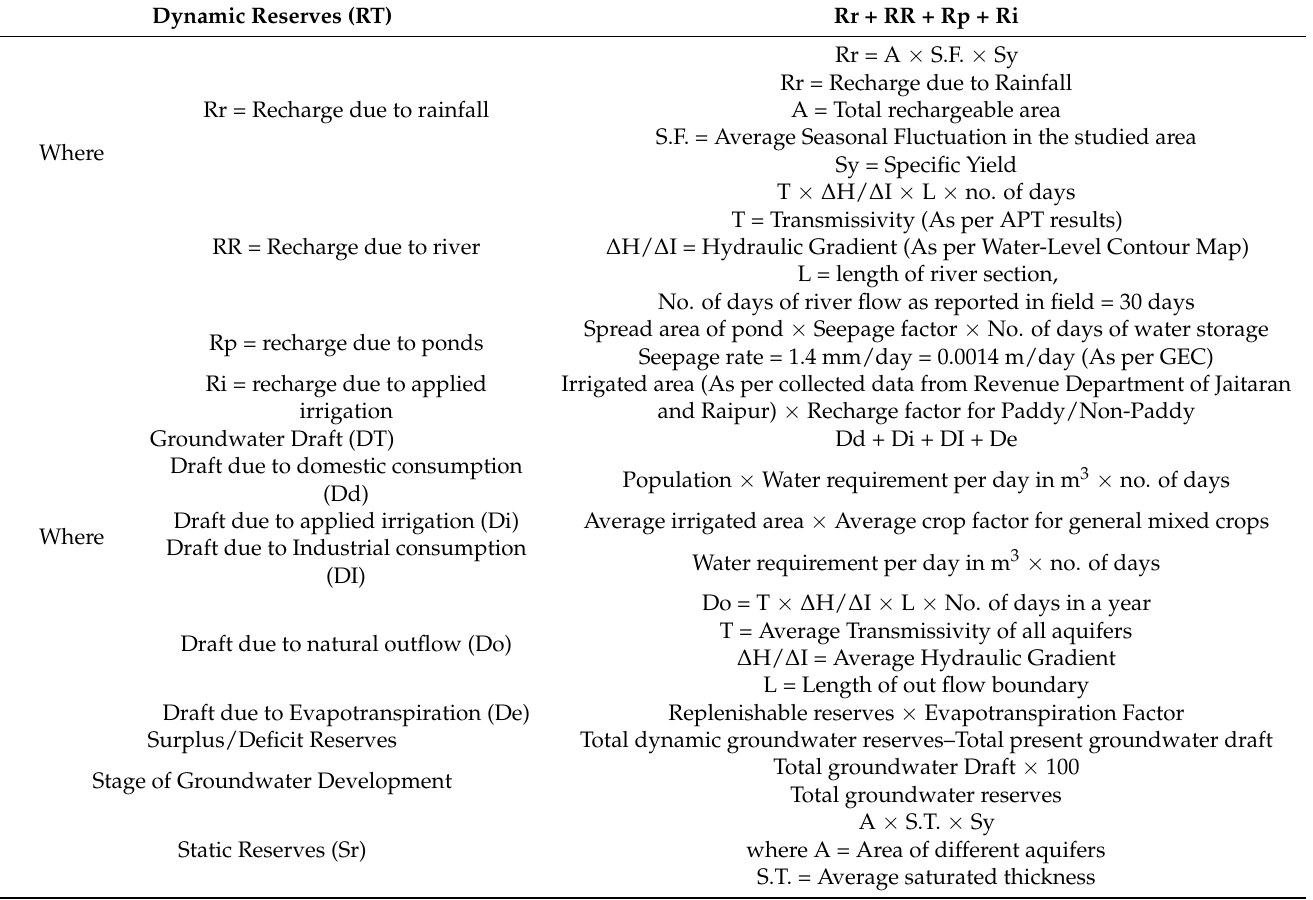
Table 1. The equations for estimation of Groundwater Resource